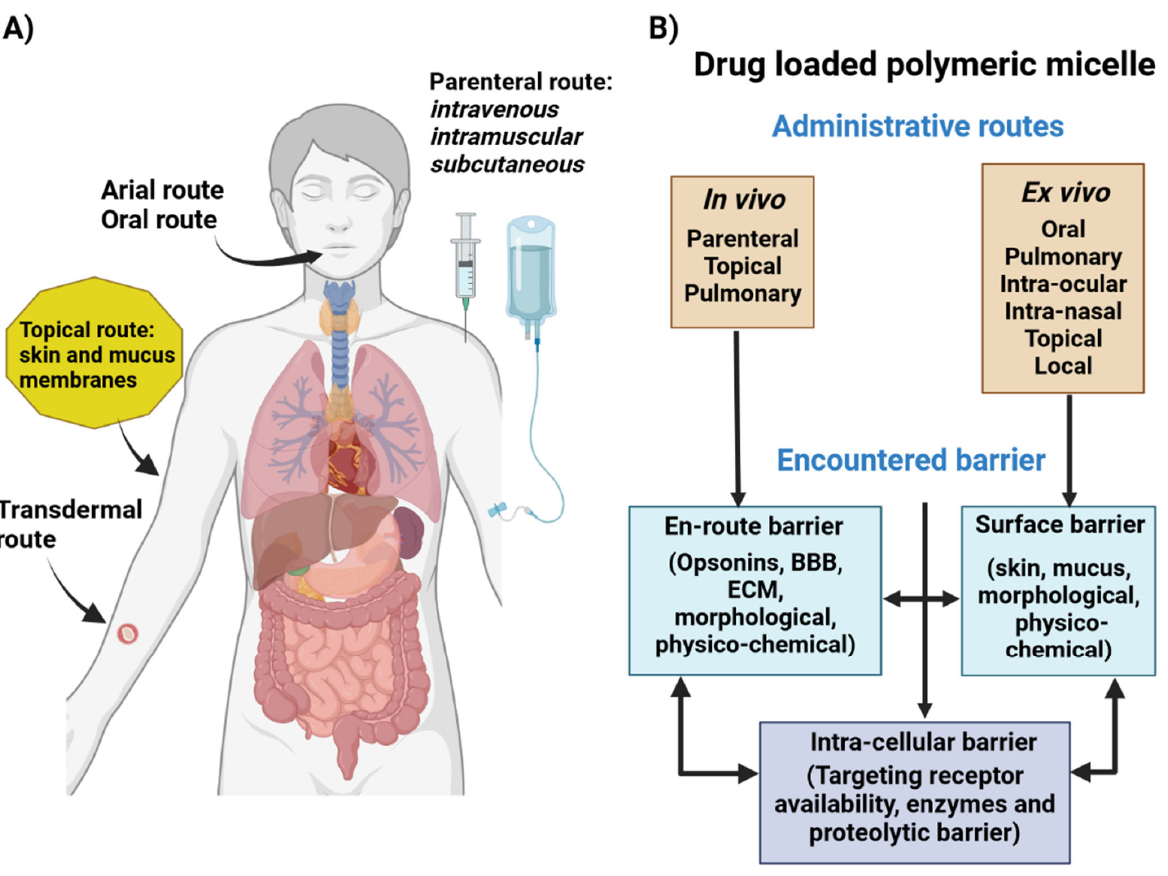
Figure 5. ( A ) Routes of nano-drug administration and ( B ) various barriers encountered by micellar systems before they reach the tumor site.